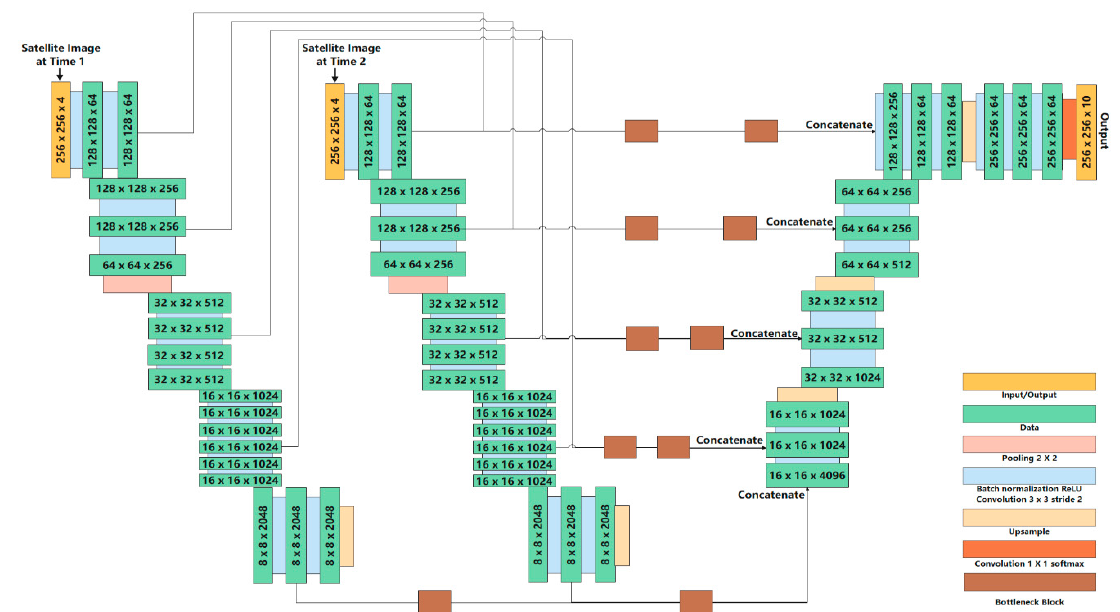
Figure 5. The general workflow of the dual-uNet-Resnet classification method.